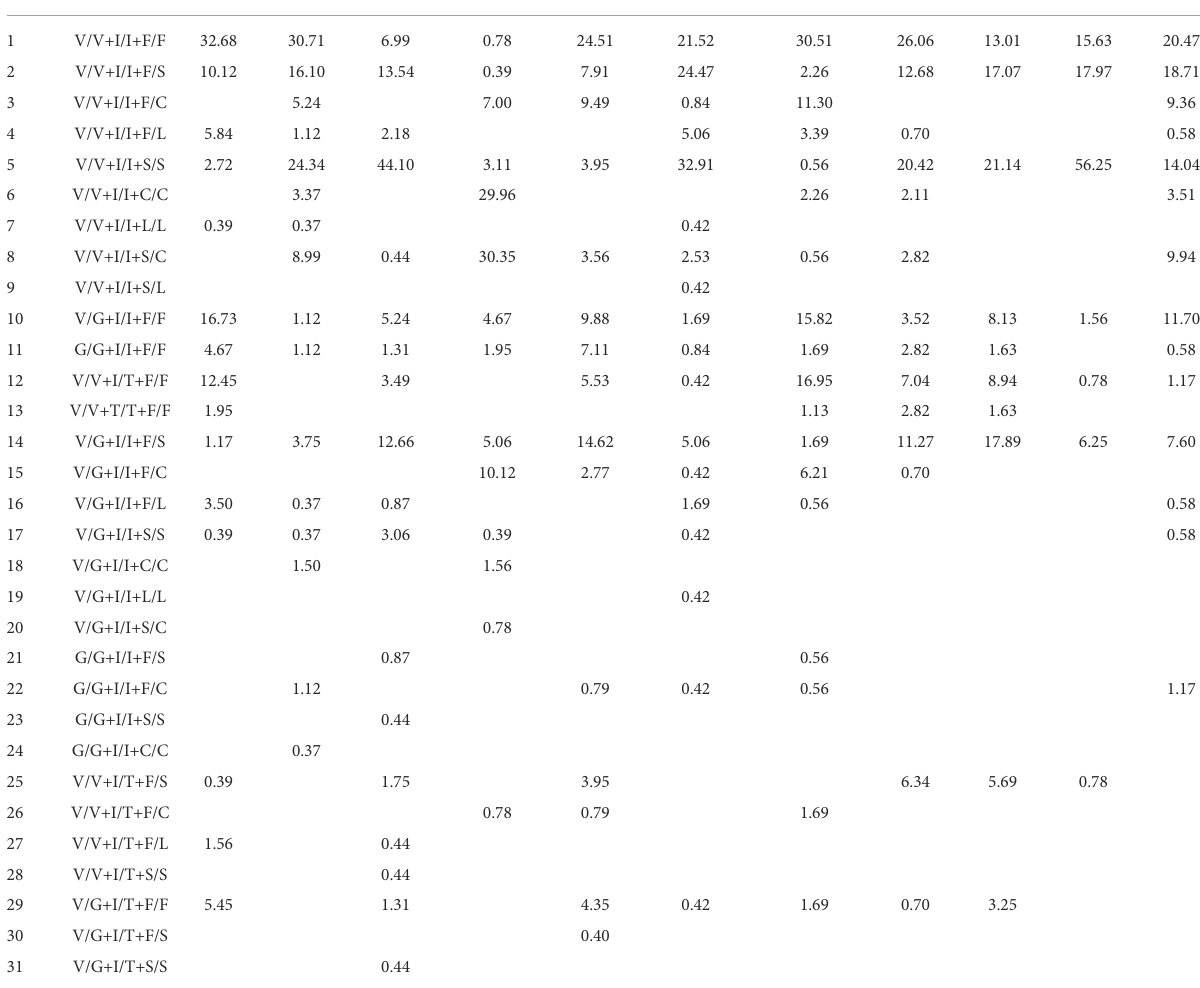
TABLE 2 Frequency distribution of triple-locus genotype combinations of Ae. albopictus in 11 provinces of China.